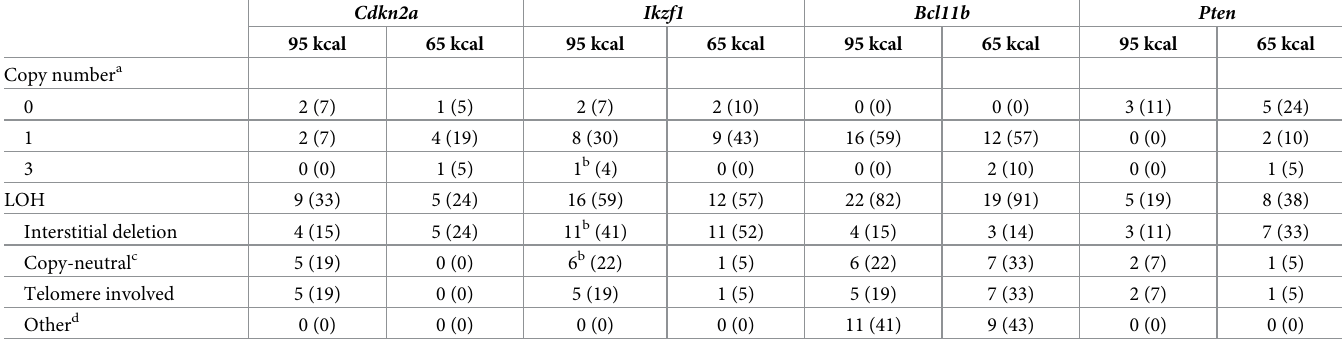
Table 1. Genomic rearrangements affecting relevant genes in radiation-induced TLs developing under different CR conditions.